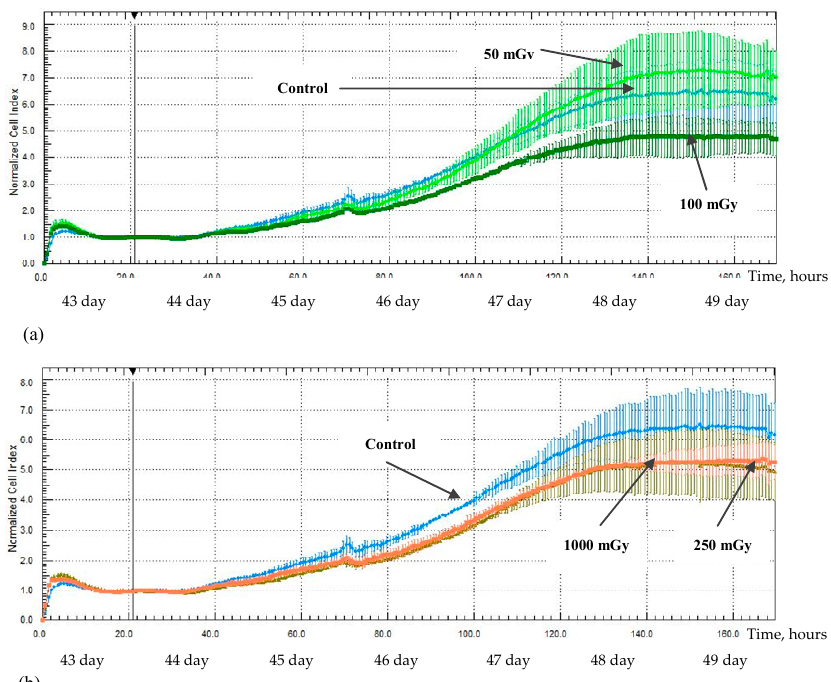
Figure 9. The proliferative activity of MSCs (n = 3) from 43 days after irradiation at doses of: ( a ) 50 mGy (light green) and 100 mGy (dark green), ( b ) 250 mGy (green) and 1000 mGy (orange).